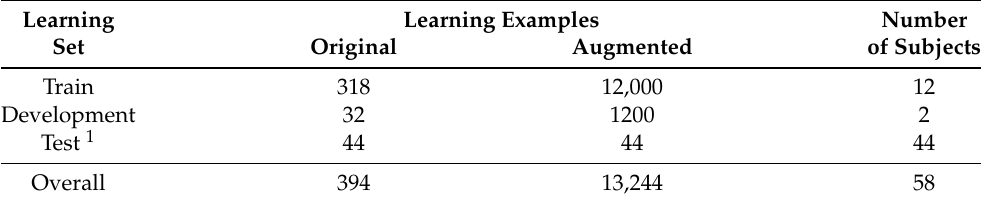
Figure 7. Visualization of certain preprocessing stages of the algorithm. ( a ) The whole X-ray image with cropped window (dashed line) and keypoints (circle) of PS. ( b ) Adaptive thresholded X-ray image with fluoroscopic lens (dotted line), points p p and p a (red line). Images were preprocessed for visualization purposes. Table 1. Gathered data sets for CNN